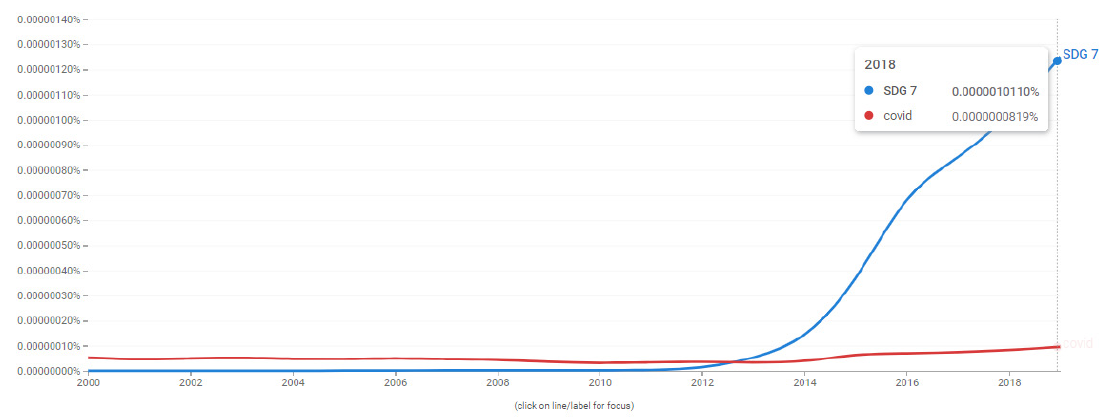
Figure 11. Ngram on the research terms of SDG 7 and COVID-19 in